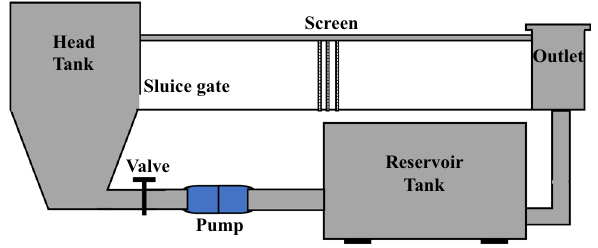
Fig. 4 Experimental setup